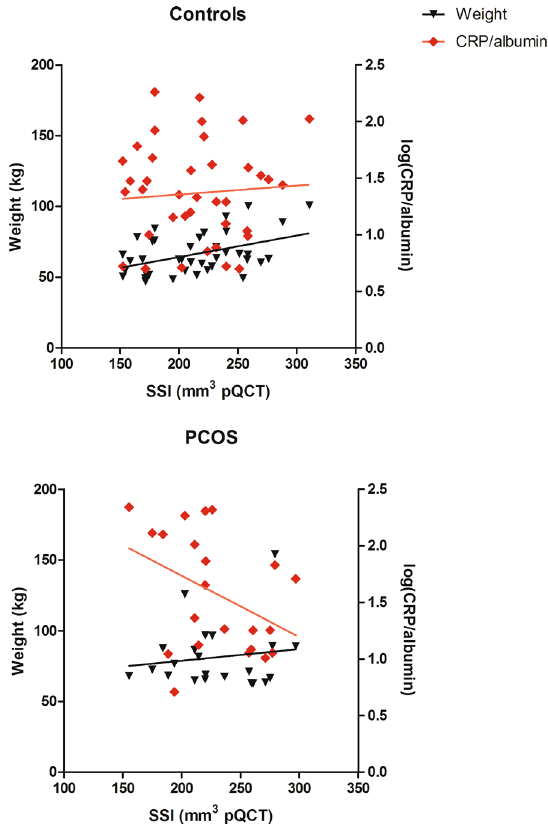
Figure 2. Linear regression of the radius strength-strain index (SSI, mm 3 ) including weight (kg) and log(CRP/ albumin) as an index of inflammation as the independent variables for women with PCOS (n = 22) and controls (n = 39). Weight was not a significant predictor of the radial SSI in women with PCOS, R 2 = 0.02, p = 0.53, but was important in the controls, R 2 = 0.19, p = 0.006. Log(CRP/albumin) was predictive of the SSI in women with PCOS, R 2 = 0.25, p = 0.02, but was not for women without PCOS, R 2 < 0.01, p =